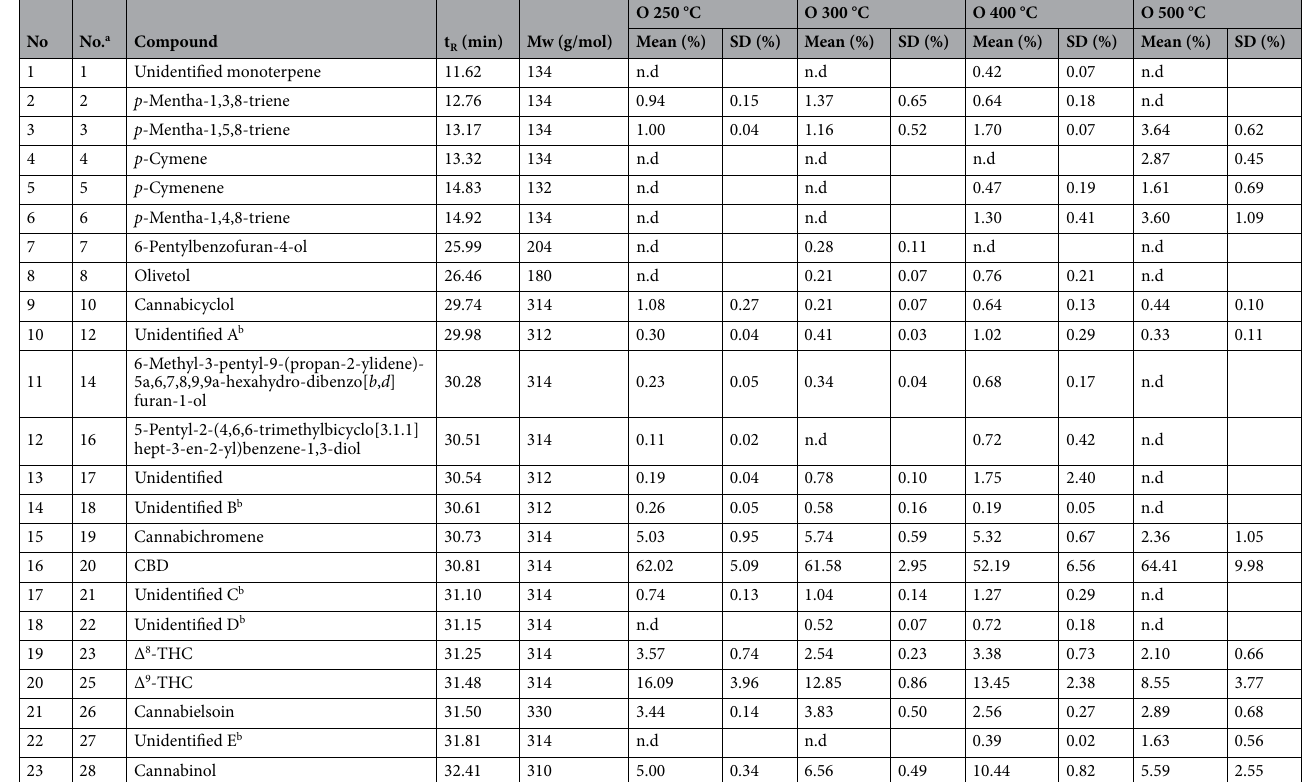
Table 2. Product distribution of CBD at various temperatures in oxidative atmosphere. Percentages are calculated using peak areas of the total ion current chromatograms. n.d. below detection limit, t R retention time, M W molecular weight. a Compound ID number. b Unidentified compounds which appear in both inert and oxidative conditions.